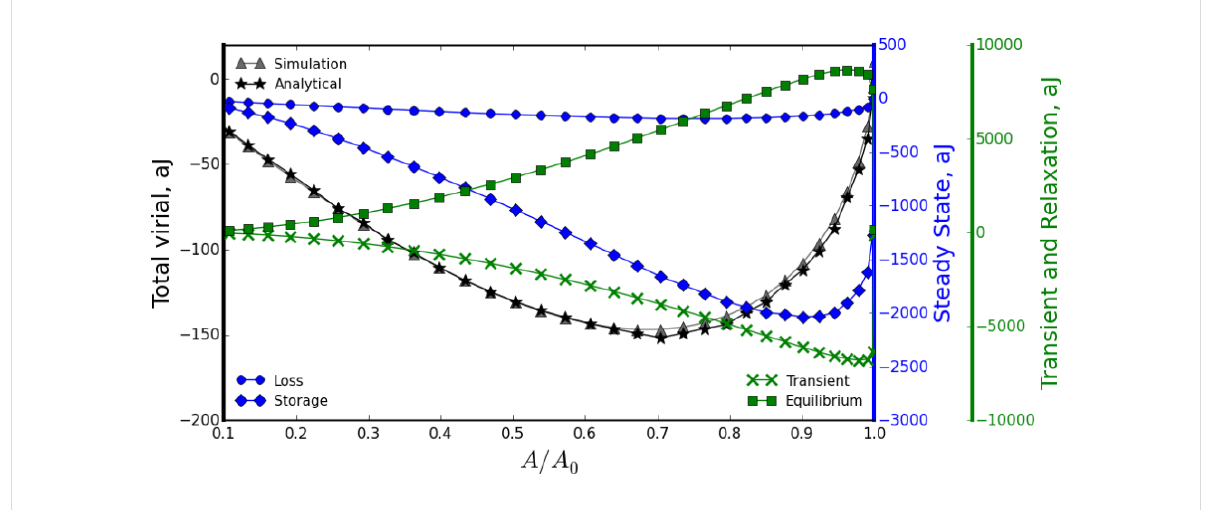
Figure 5: Virial spectroscopy curve, showing the virial as a function of the ratio between tapping amplitude and free amplitude ( A / A 0 ). The plot shows how Equation 31 can separate the total virial into meaningful viscoelastic contributions. The simulation results (triangle symbols) correspond to the case of a flat-punch probe tapping on a polyisobutylene sample (this is the same simulation as the one described in the caption of Figure 4). The total virial is decomposed into terms related to G ′ ( ω ), G ″ ( ω ), G ( t ), and the transients of the harmonic force. The symbol scheme is the same as in Figure